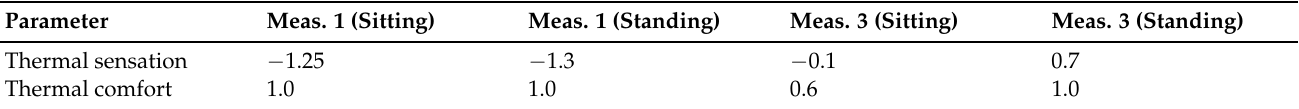
Figure 12. Results of the passengers survey. ( a , b ) show the thermal comfort of all the test subjects for Meas. 1 and Meas. 3, respectively. Table 11. Average thermal sensation and comfort of the test subjects obtained from the survey. Parameter Meas. 1